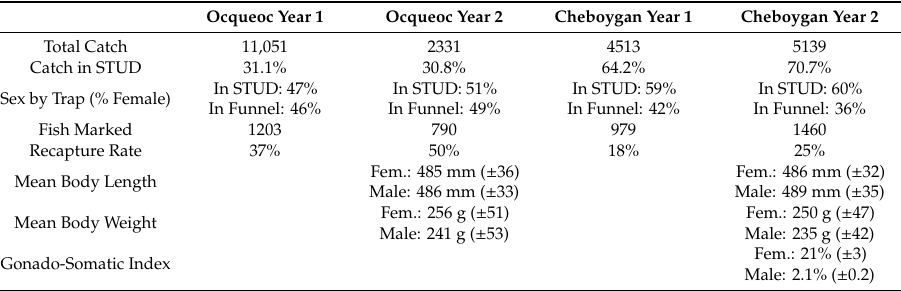
Figure 3. Daily lamprey catch of two experimental traps at Ocqueoc and Cheboygan Rivers (blue line) and percentage of the daily catch that was female lamprey (orange line, five-day moving mean). Table 1. Summary of catch statistics and characteristics of lamprey caught in two trap types in the Ocqueoc and Cheboygan Rivers. Recapture rates are the percentage of marked fish that returned to both traps combined at each site. Values in parentheses are standard deviations. Blank cells indicate no measurement taken.